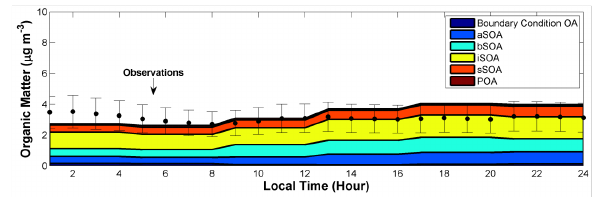
Figure 3. Diurnally averaged organic aerosol mass concentrations for the FAME-08 period segregated by source class. Also shown are the measurements taken by the AMS with the corresponding uncertainty range.